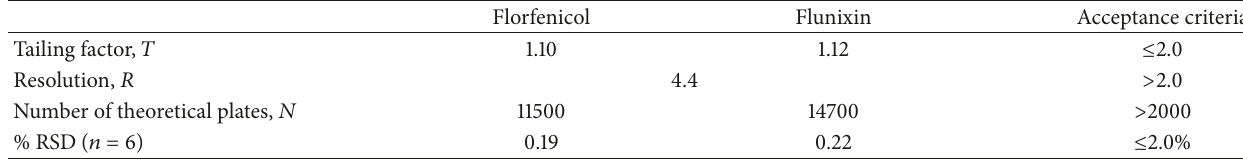
Table 7: System suitability parameters of the current